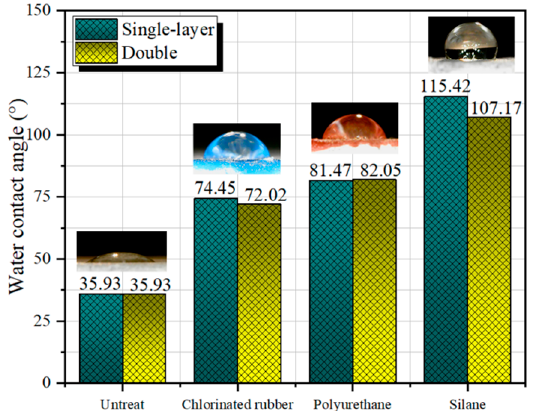
Figure 10. Microdroplet morphology and water contact angle of specimens (water–binder ratio 35 wt.%). 35